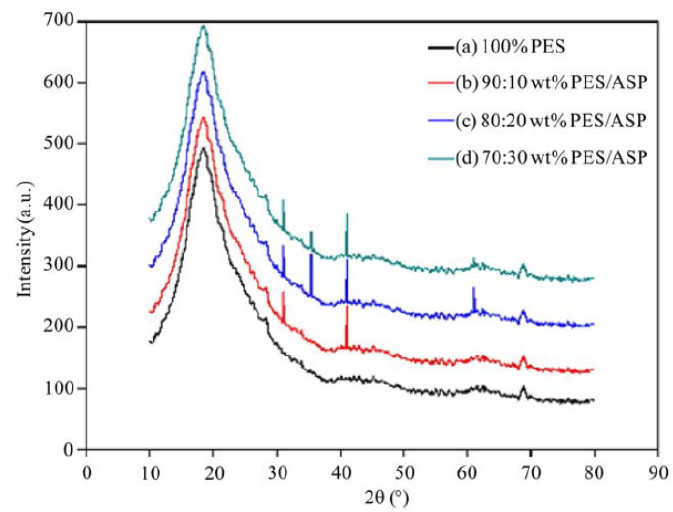
Figure 15. XRD data of a mixed-matrix membrane of polyethersulfone membrane with aluminosilicate particles [66].